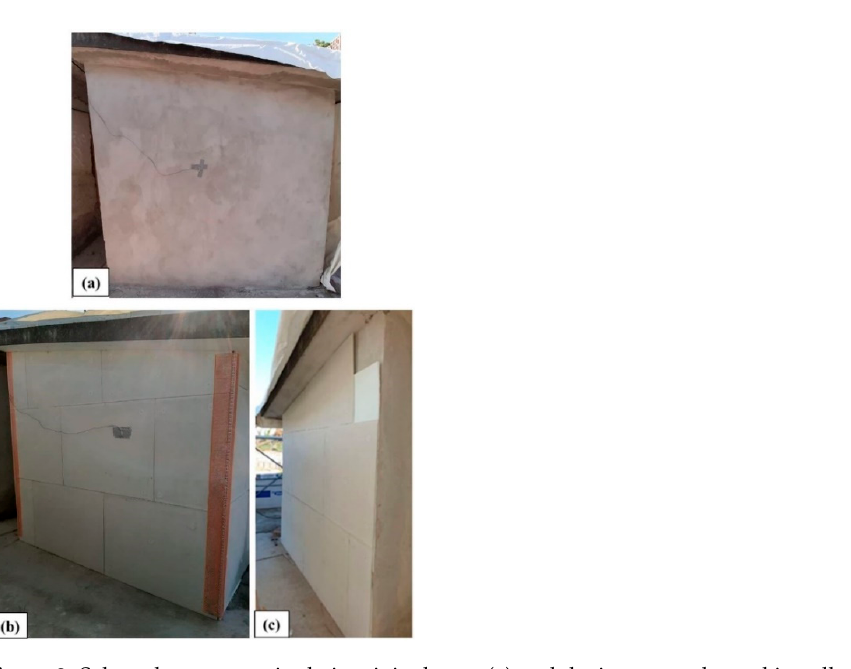
Figure 2. Selected test rooms in their original state ( a ) and during aerogel panel installation ( b , c ).